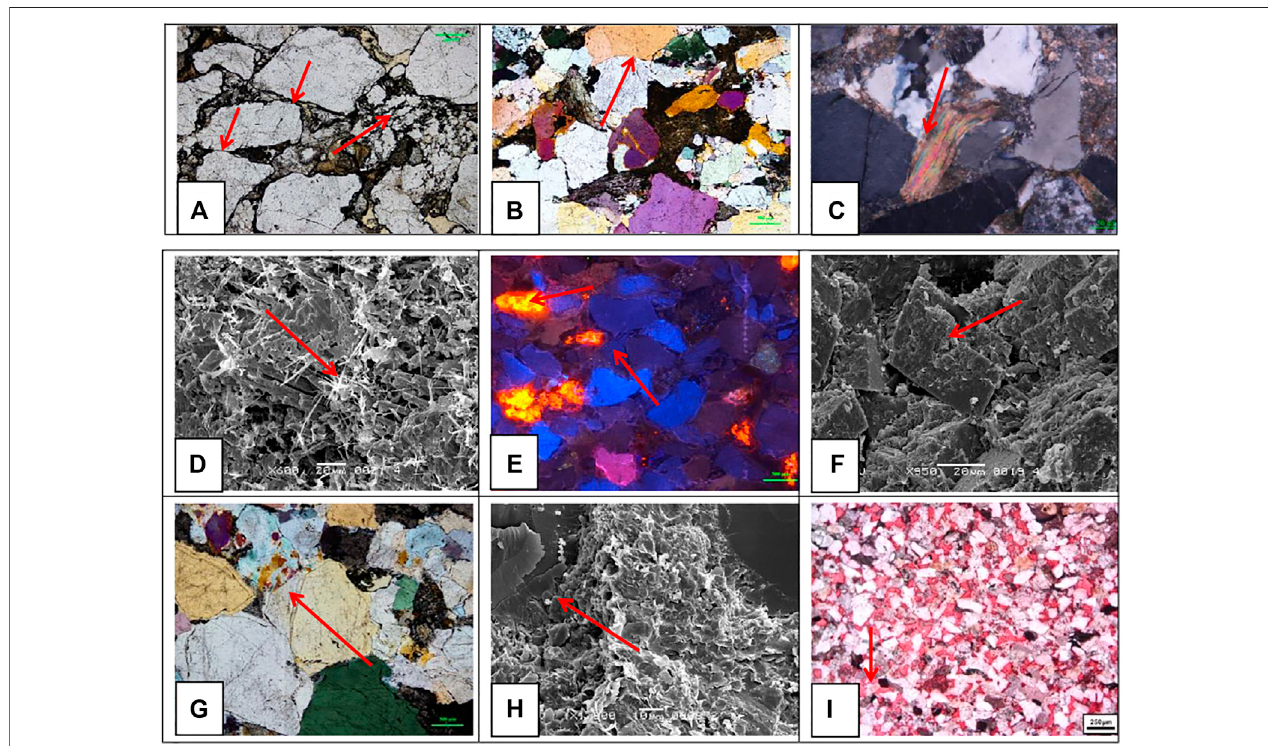
FIGURE 6 | Cementation types (red arrows) of the Upper Paleozoic reservoirs in the Dongpu Depression. (A) Point-line contacts and quartz fractures of the Upper ShiheziFormationoftheKai35 – 2Wellatawelldepthof2,704 m; (B) Concavo-convexcontactsoftheLowerShiheziFormationoftheMa71 – 1Wellatawelldepthof3,597m; (C) BendingdeformationsofthemicaoftheUpperShiheziFormationintheWengu2YX-16Wellatawelldepthof4,079 m; (D) IllitecementationoftheUpperShiheziFormationofthe Ma17Wellatawelldepthof3,460.7 m; (E) Cementationofthecalcite(orange)andkaolinite(darkblue)oftheUpperShiheziFormationoftheQinggu2-1Wellatawelldepthof 3,796 m; (F) DolomitecementationoftheTaiyuanFormationoftheDonggu2Wellatawelldepthof2,560 m; (G) QuartzsecondaryenlargementoftheUpperShiheziFormationof theMa17 – 1Wellatawelldepthof3,460 m; (H) PyritecementationoftheTaiyuanFormationoftheMagu6Wellatawelldepthof3,095.80 m; (I) Calcitemetasomatizedofthequartz and rock fragments of the Shiqianfeng Formation of the Chang 4 Well at a well depth of 2,446 m.